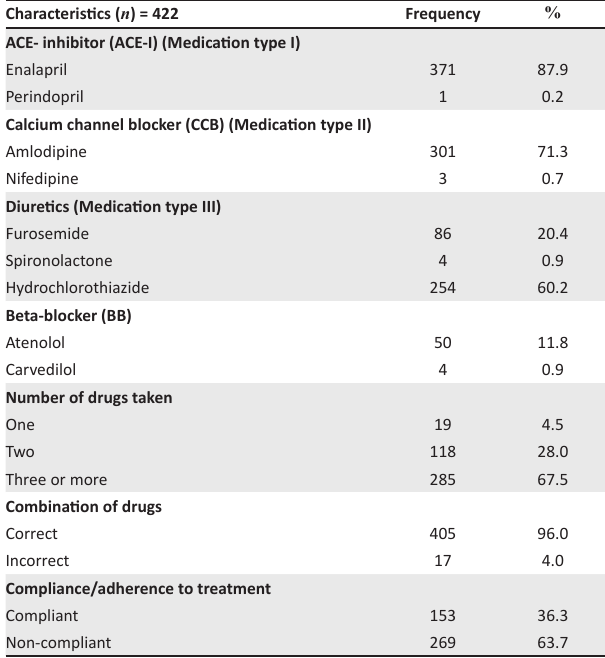
TABLE 4: Treatment/medication characteristics of